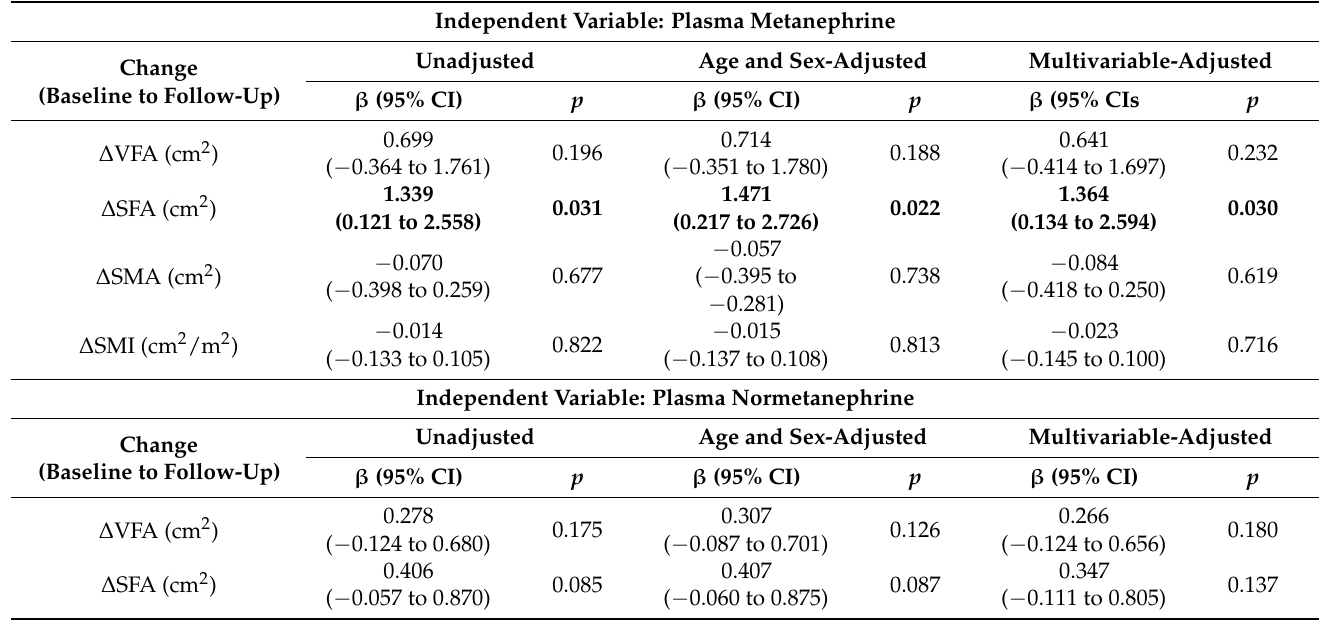
Table 3. Association of baseline catecholamine metabolites with changes in computed tomography- determined body composition before and after adrenalectomy in patients with pheochromocytoma. Independent Variable: Plasma Metanephrine.